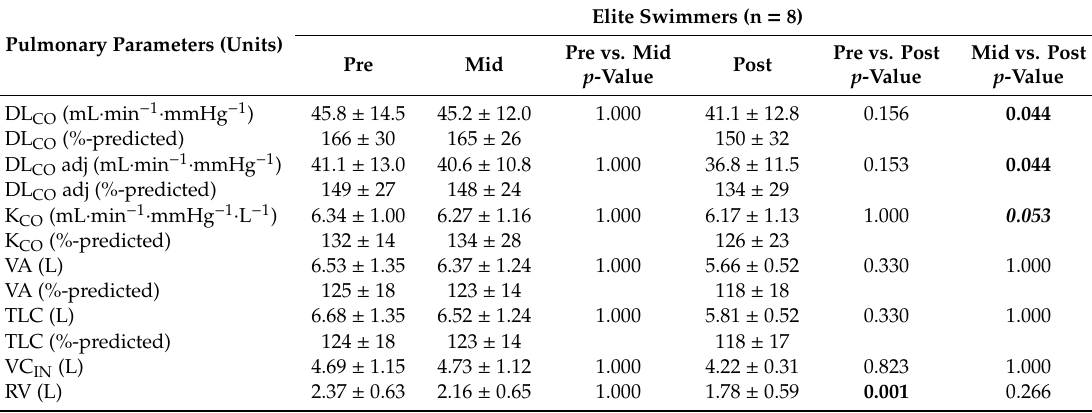
Table 3. Lung capacity and pulmonary gas di ff usion parameters before and after a combined session (day 10) of swimming at 1850 m in hypobaric hypoxia and cycling at 3000 m in normobaric hypoxia.